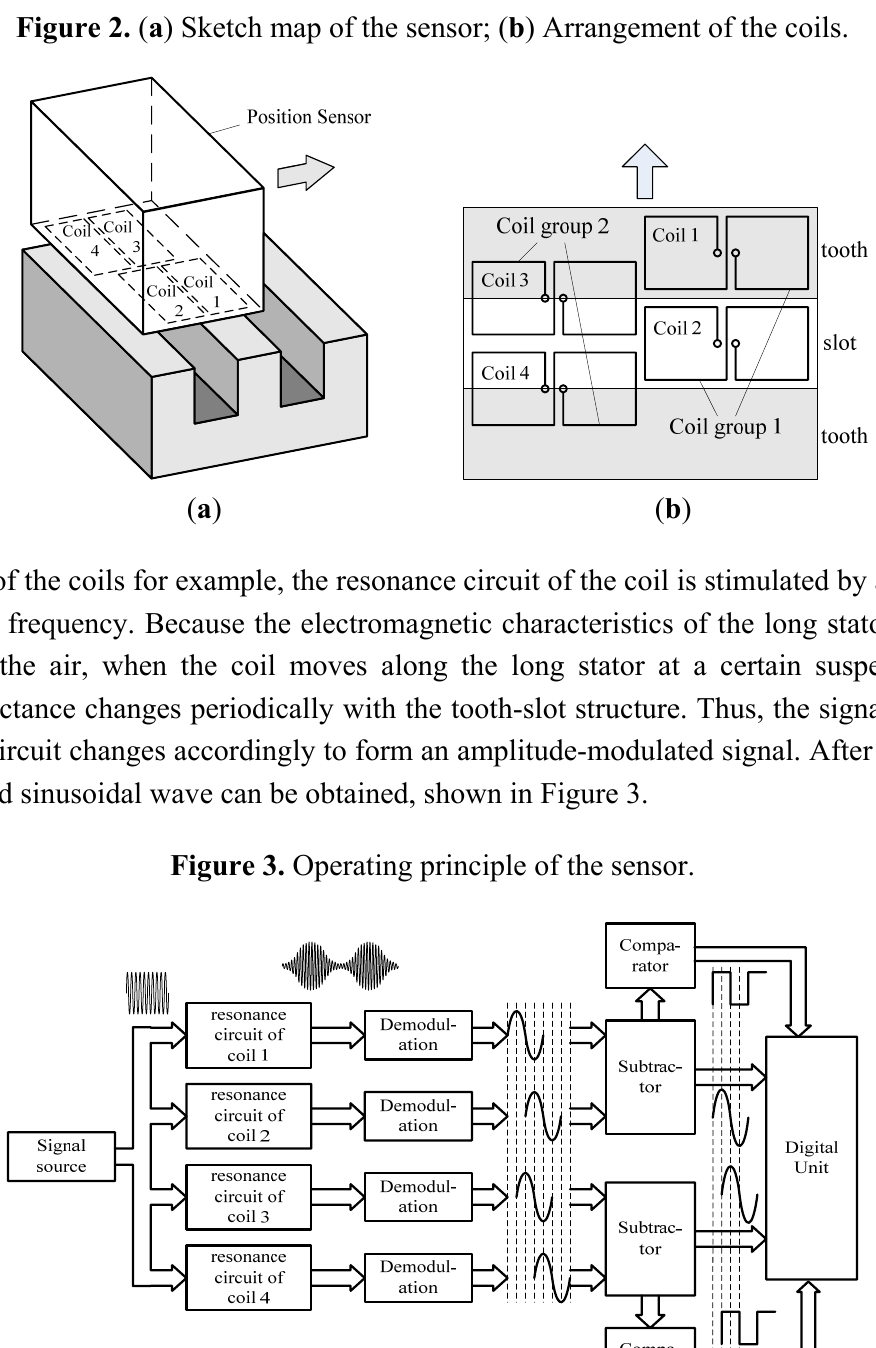
Figure 2. ( a ) Sketch map of the sensor; ( b ) Arrangement of the coils.